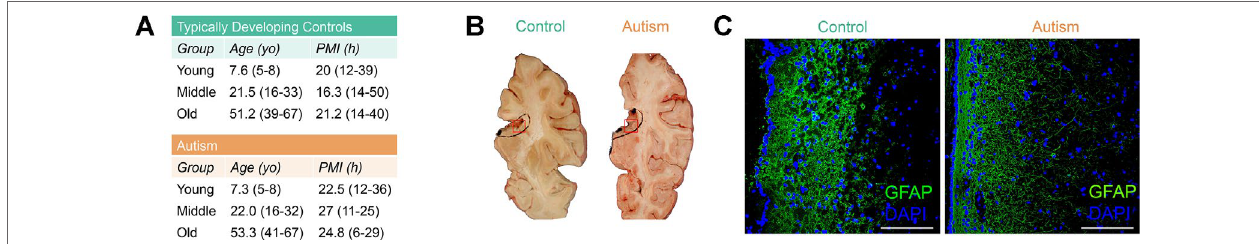
FIgURE 1 | Postmortem subventricular zone (SVZ) tissue from autism-diagnosed and typically developing individuals. (A) Postmortem tissue characteristics. yo: years old; PMI: postmortem interval. (B) Representative identification of subventricular zone region of interest from fresh frozen postmortem tissue. Red box indicates regions used for analyses. (C) Immunofluorescence micrograph displaying layered organization of SVZ region. Glial fibrillary acidic protein (GFAP) (green color) and 4 ′ ,6-diamidino-2-phenylindole (DAPI) (blue color) labeling. Scale bar: 100